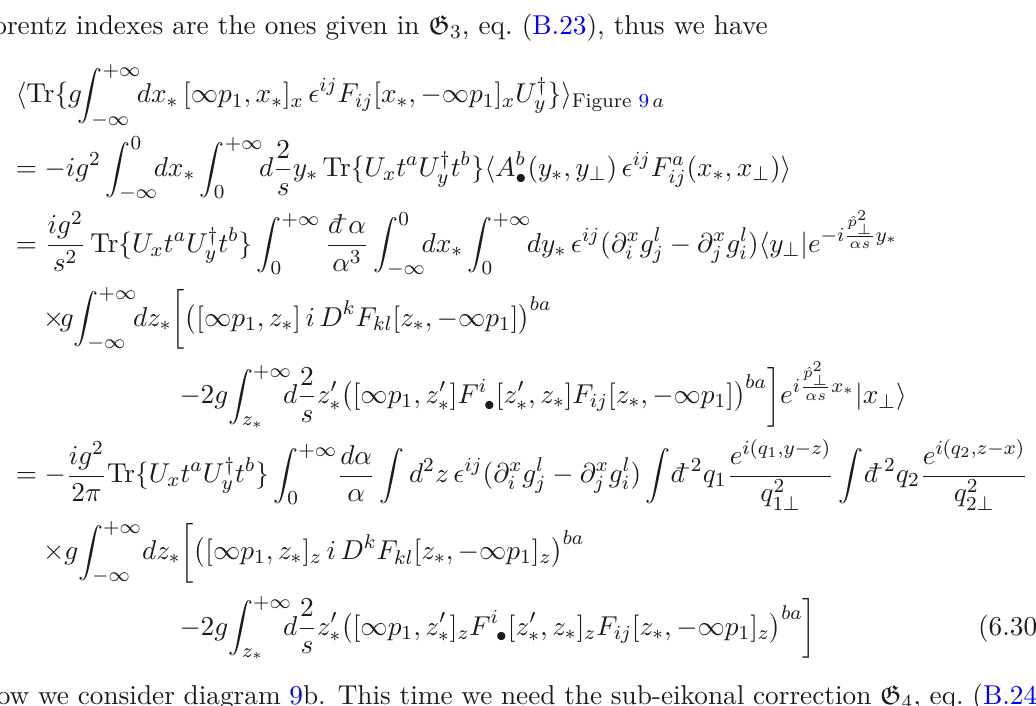
Figure 9 . Diagrams with F ij outside shock-wave. Here the gluon propagator, which represent the quantum loop, has gluon sub-eikonal corrections. The gray circle with an x on it symbolizes the F ij operator: it is quantum when it is on the Wilson-line and it is functionally integrated to create the gluon propagator; it is classical when it is in the shock-wave red